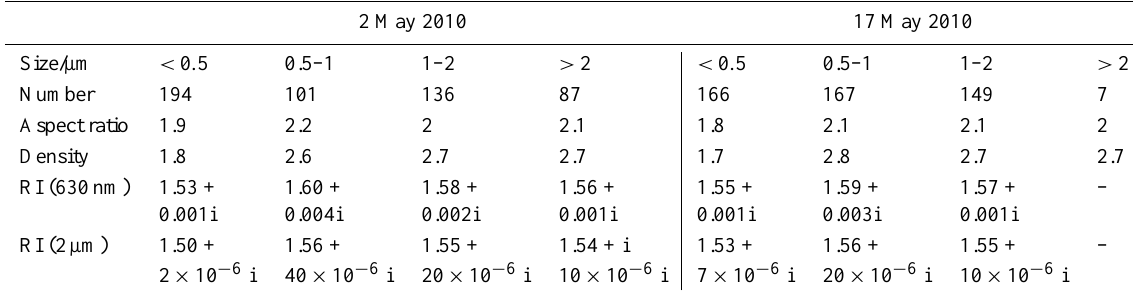
Table 4. Number of investigated particles, measured two-dimensional aspect ratio and calculated density and complex refractive index (RI) values for different particle size classes and wavelengths.